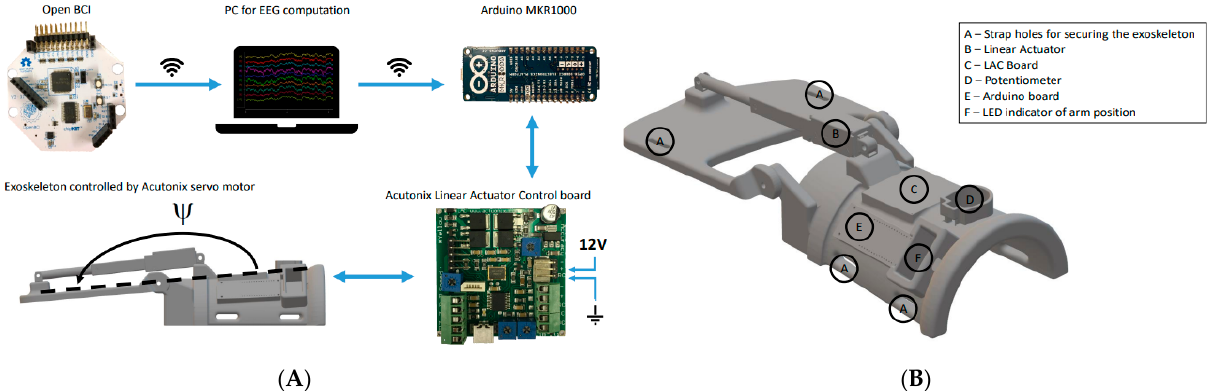
Figure 12. ( A ) The hardware setup. The Arduino control board and Linear Actuator were mounted on the exoskeleton. The signals were transferred to the OpenViBE PC running OpenViBE via a wireless connection. When an imagined wrist extension was identified, a trigger was transmitted to the Arduino on the exoskeleton through wireless communication. A wire linked the Arduino to the Linear Actuator Control board. A 12 V power supply was used to power the Linear Actuator Control board. A wire linked the motor to the Linear Actuator Control board. ( B ) The 3D-printed exoskeleton. The contact surfaces of the forearm were padded with foam to improve comfort. Velcro straps were used to fix the exoskeleton to the subject’s forearm [102].